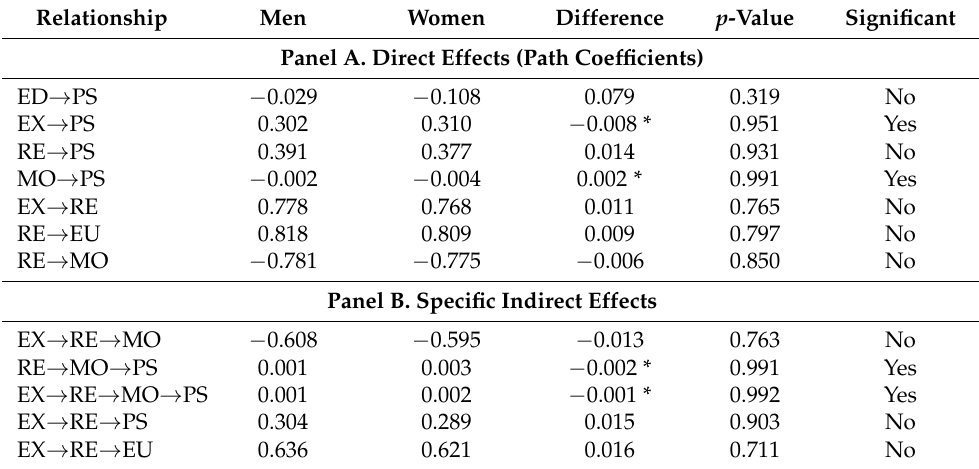
Table 9. Henseler’s multi-group analysis